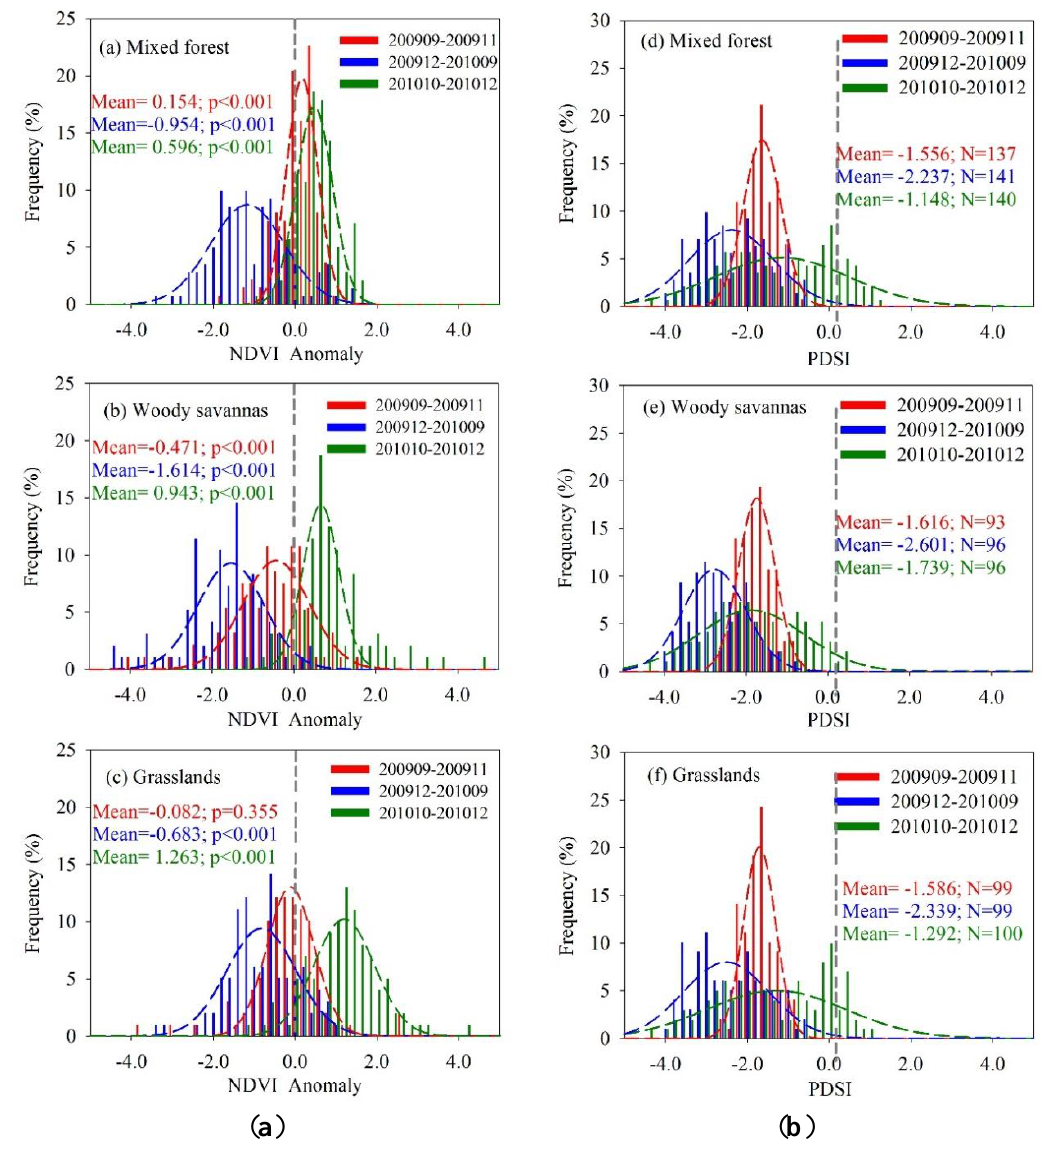
Figure 5. V egetation responses to drought under different drought stages. ( a ) NDVI anomalies frequency distribution; and ( b ) PDSI frequency distribution. The histograms of PDSI frequency distribution were calculated within the same area as the NDVI anomaly frequency